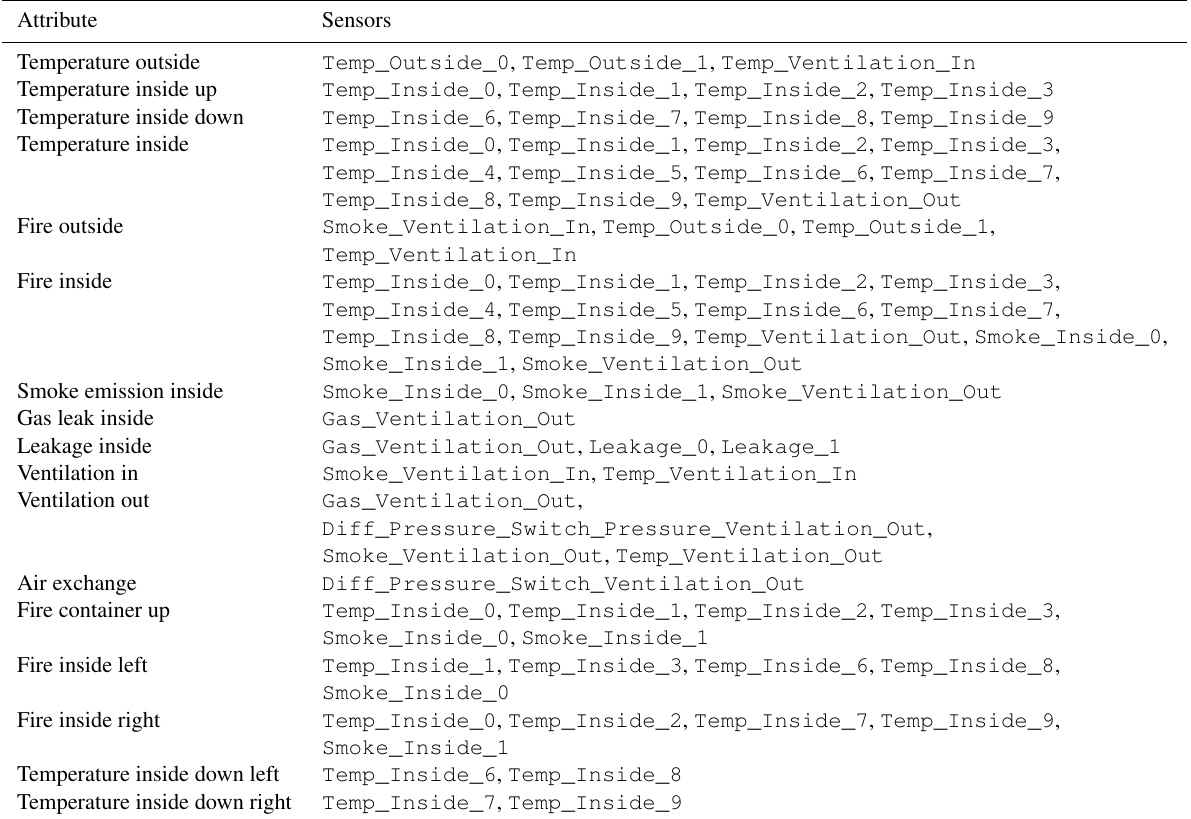
Table A1. List of all attributes and their associated sensors. Attributes are named according to their position (e.g. outside, inside up, ventila- tion in). Additionally, most attributes also include a monitored physical property (e.g. temperature) or semantics (e.g.